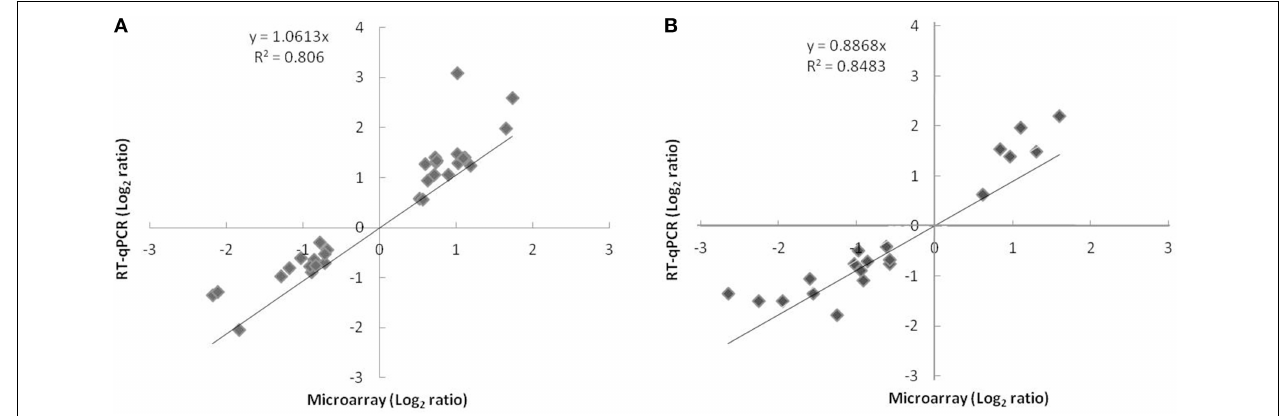
represent up- and down-regulation in the presence of nitrate and nitrite. Each data point is calculated from averages of biological triplicates.